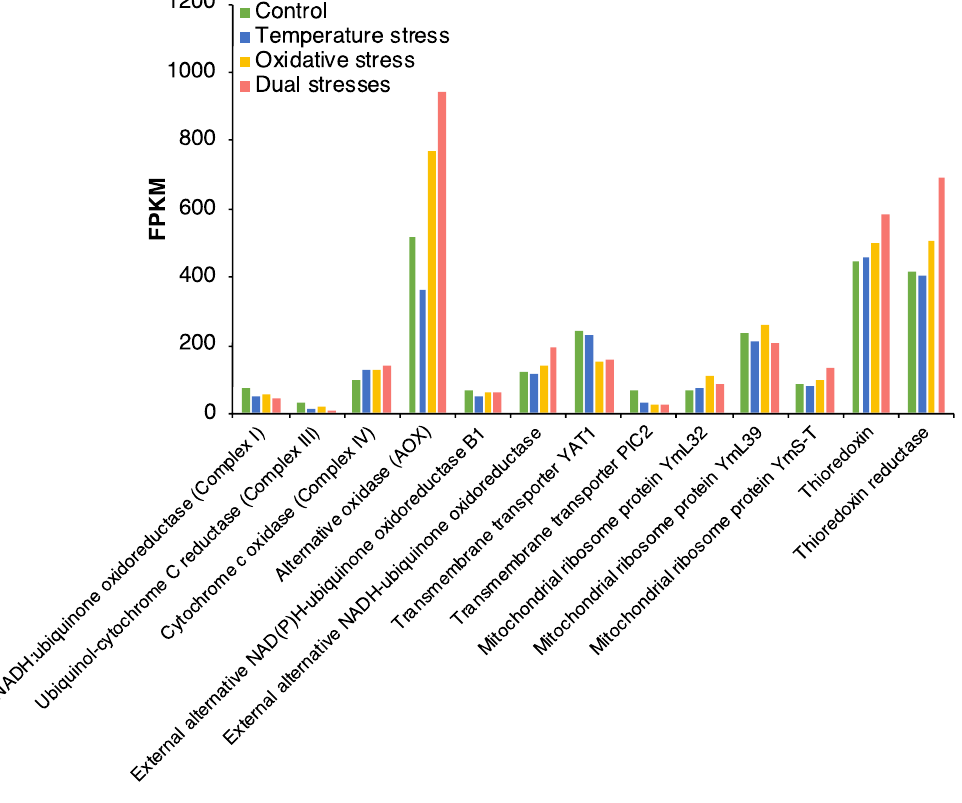
Figure 6. Expression of selected genes encoding mitochondrial function-related enzymes. Bars indicate the expression (FPKM) of genes under different treatment